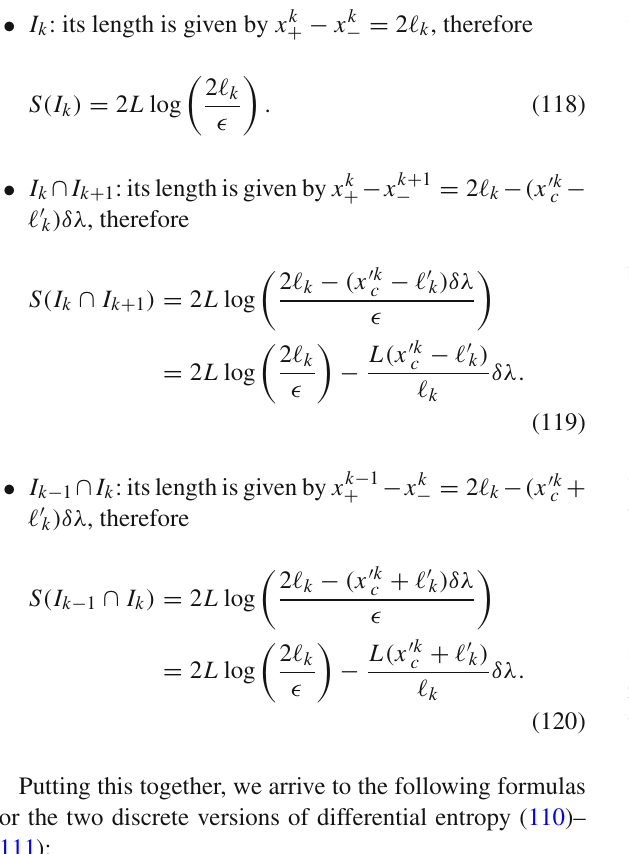
Fig. 12 Discrete reconstruction of differential entropy. To each point of the (red) curve ( x (λ k ), z (λ k )) we can associate a geodesic (depicted in solid orange) whose endpoints reach the AdS boundary at the points x k ± , specifying a boundary interval I k . The discrete versions of differ- ential entropy (110) and (111) involve a particular combination of the entanglement entropy of such intervals S ( I k ) , as well as the entangle-